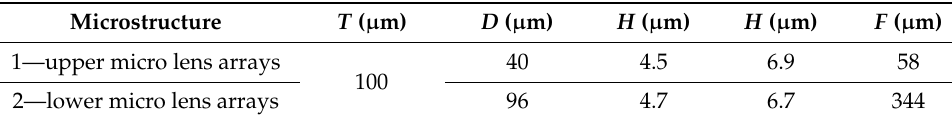
Figure 5. The picture of the MLLA fabricated using our method. Table 1. The parameters of the mask used to fabricate the MLLA.